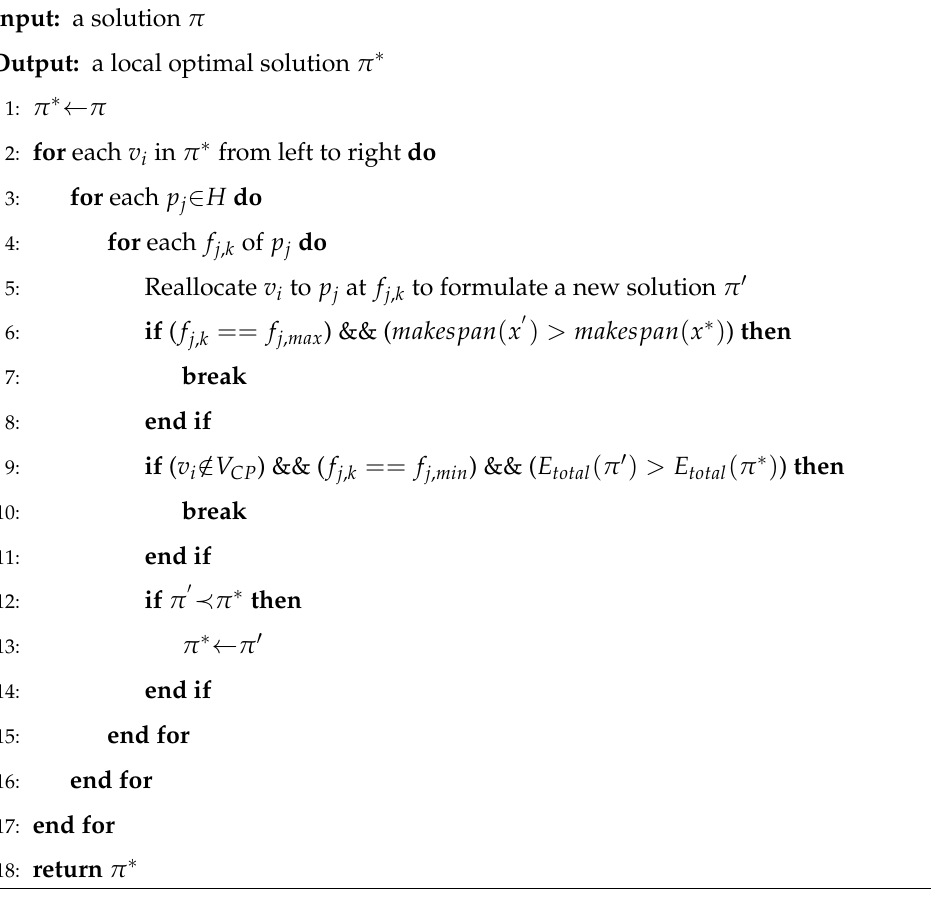
Algorithm 4. Local search with